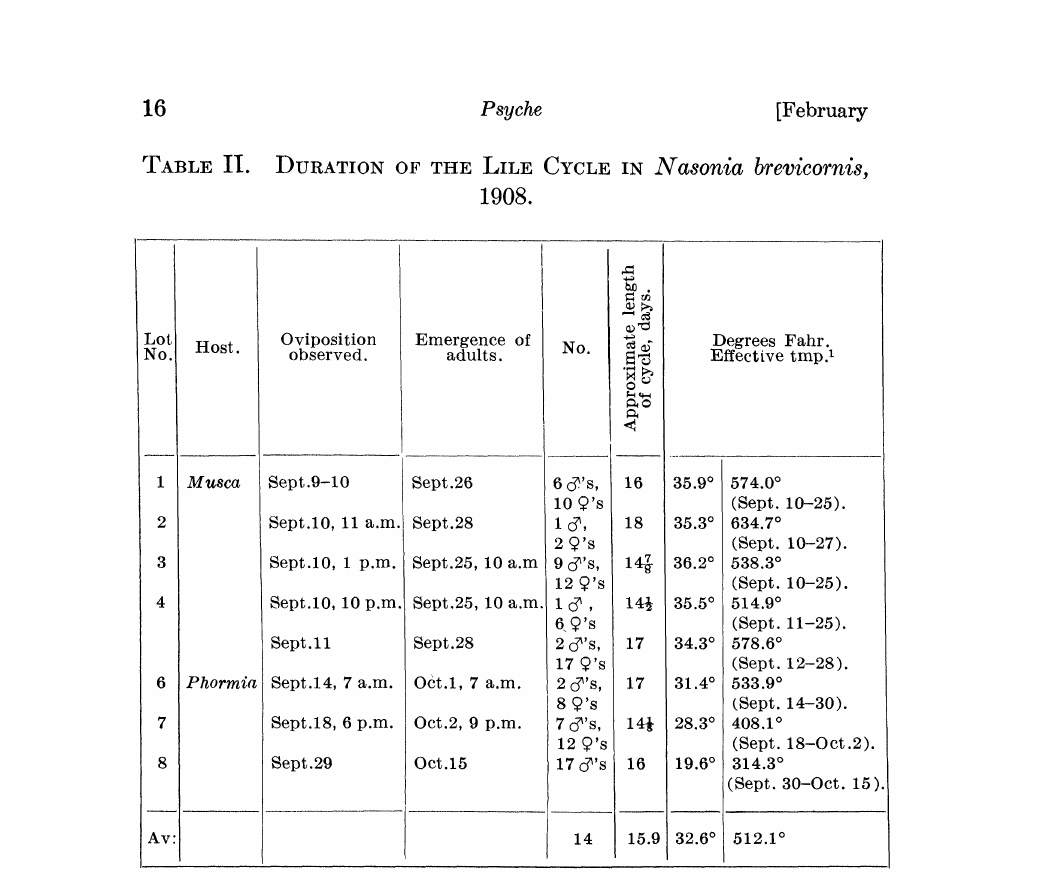
DURATION OF THE LILE CYCLE IN Nasonia brevicornis,